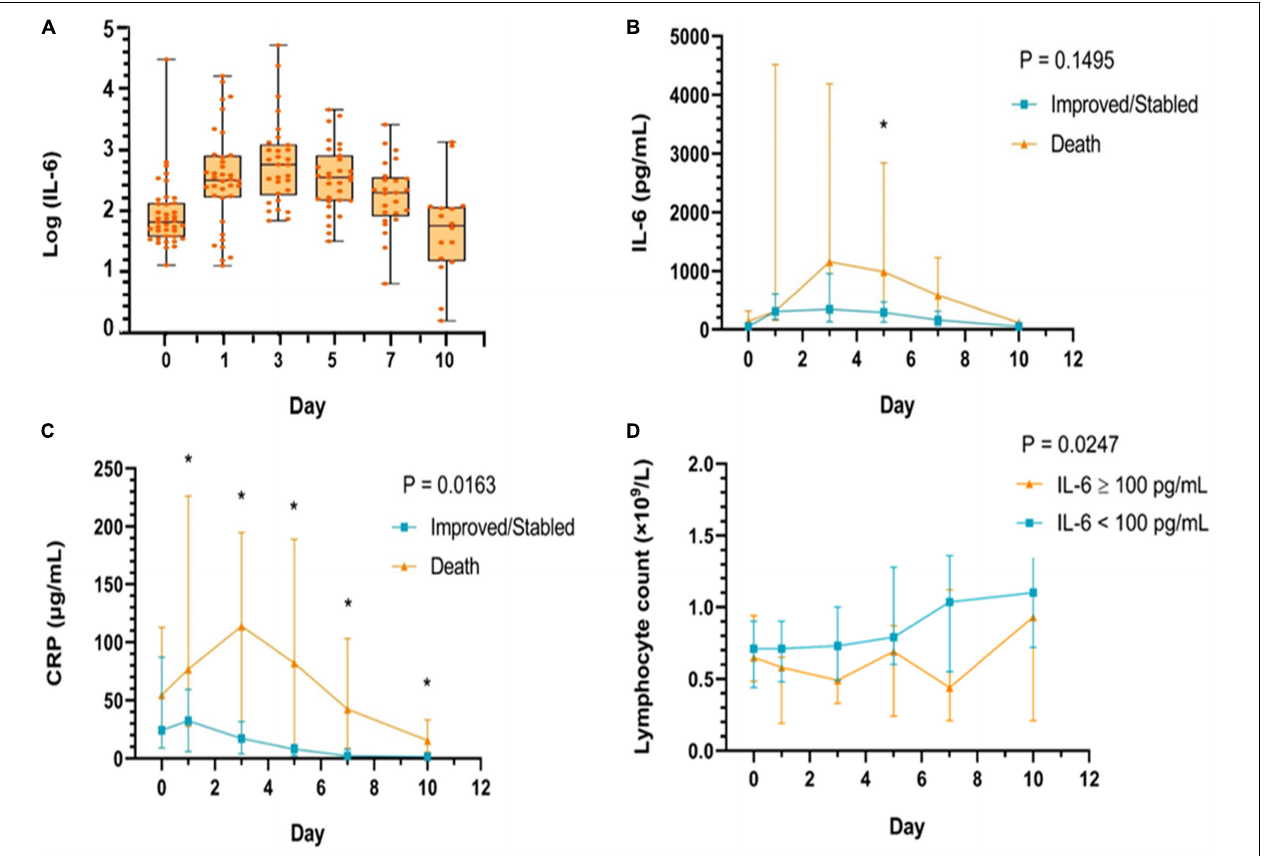
FIGURE 2 | The changing trend of IL-6 levels before and after tocilizumab treatment (A) . The change of IL-6 (B) and hs-CRP (C) levels, respectively, during the tocilizumab treatment categorized by outcomes (improvement and death) at baseline, day 1, day 3, day 5, day 7, and day 10; (D) The change of lymphocytes (LYM) during the tocilizumab treatment categorized by baseline IL-6 level (using median value 100 pg/ml as cut-off value) at baseline, day 1, day 3, day 5, day 7, and day 10. * P < 0 . 05 compared with the improvement and death